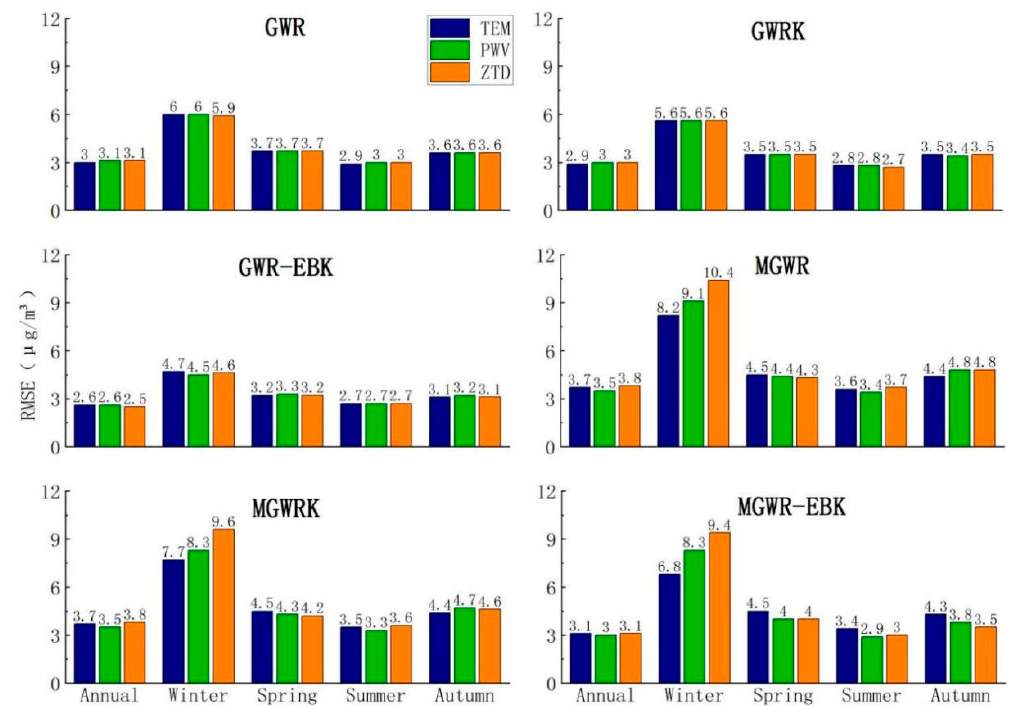
Figure 12. The RMSE values of the overall results obtained by the interpolation for the six models.